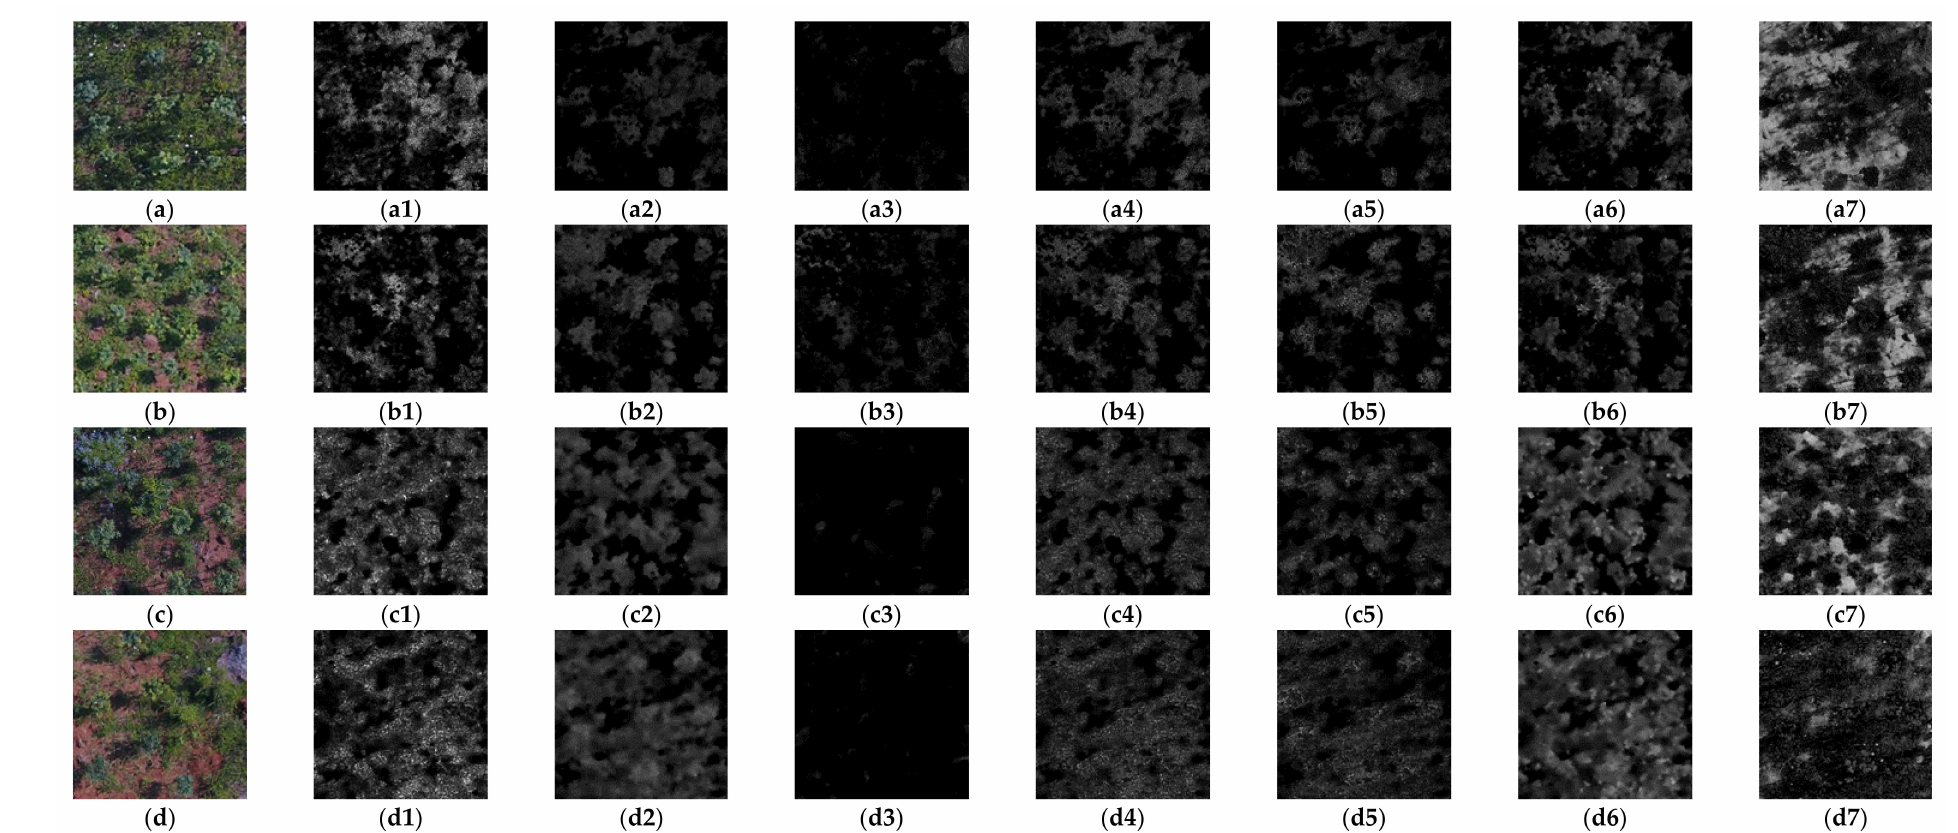
Figure A1. Detail of the UAV image from the study area. ( a ) 35 m (1.34 cm spatial resolution), HFVC, IB; ( a1 – a7 ) the result of transformation of ( a ) with image spectral index in Table 3. ( b ) 35 m, HFVC, SB; ( b1 – b7 ) the result of transformation of ( b ) with image spectral index in Table 3. ( c ) 20 m (7.34 mm spatial resolution), MFVC, IB; ( c1 – c7 ) the result of transformation of ( c ) with image spectral index in Table 3. ( d ) 20 m, MFVC, IB; ( d1 – d7 ) the result of transformation of ( d ) with image spectral index in Table